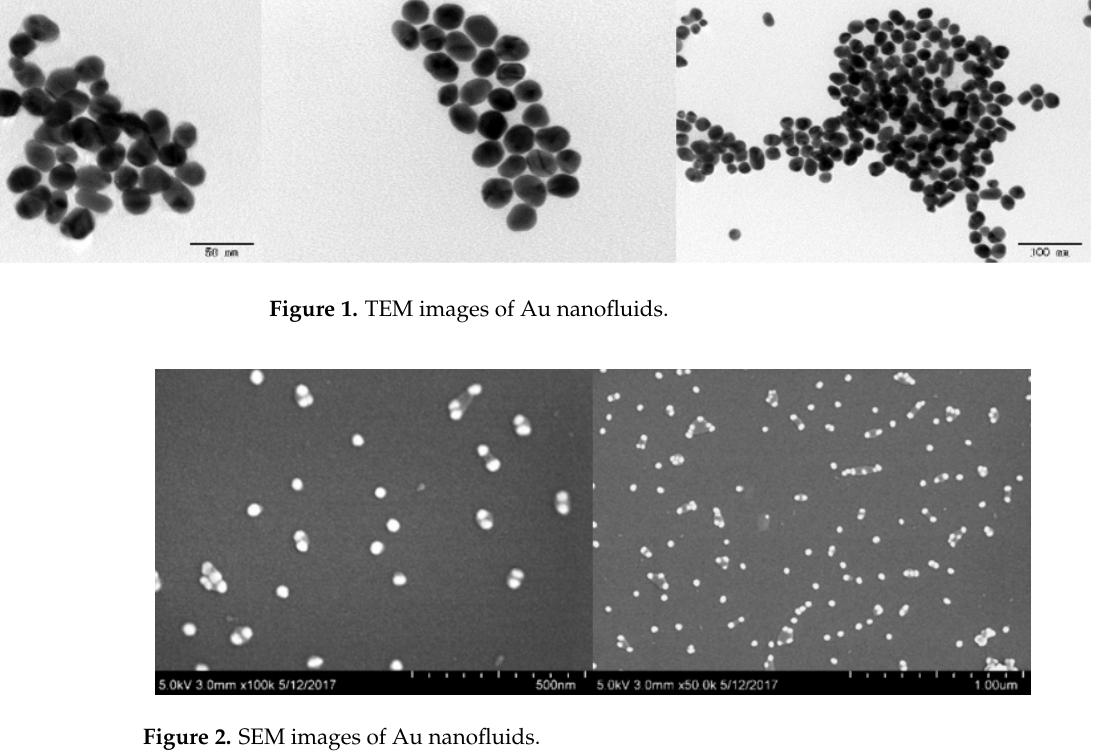
Figure 2. SEM images of Au nanofluids.